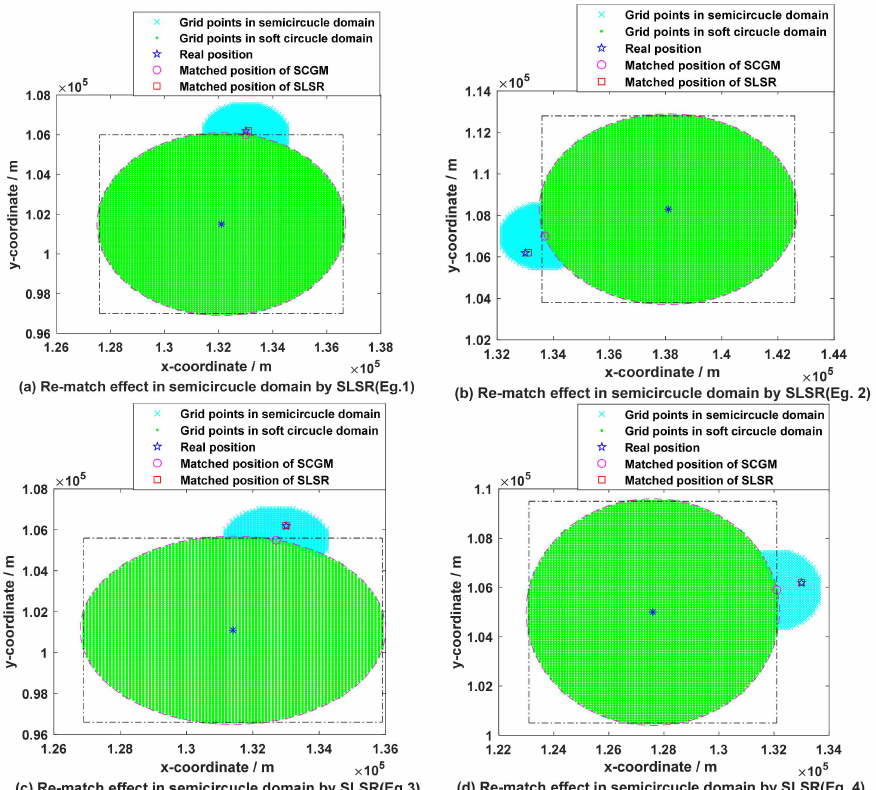
Figure 8. Semicircular domain re-matching diagram of SLSR for out-of-domain mismatching